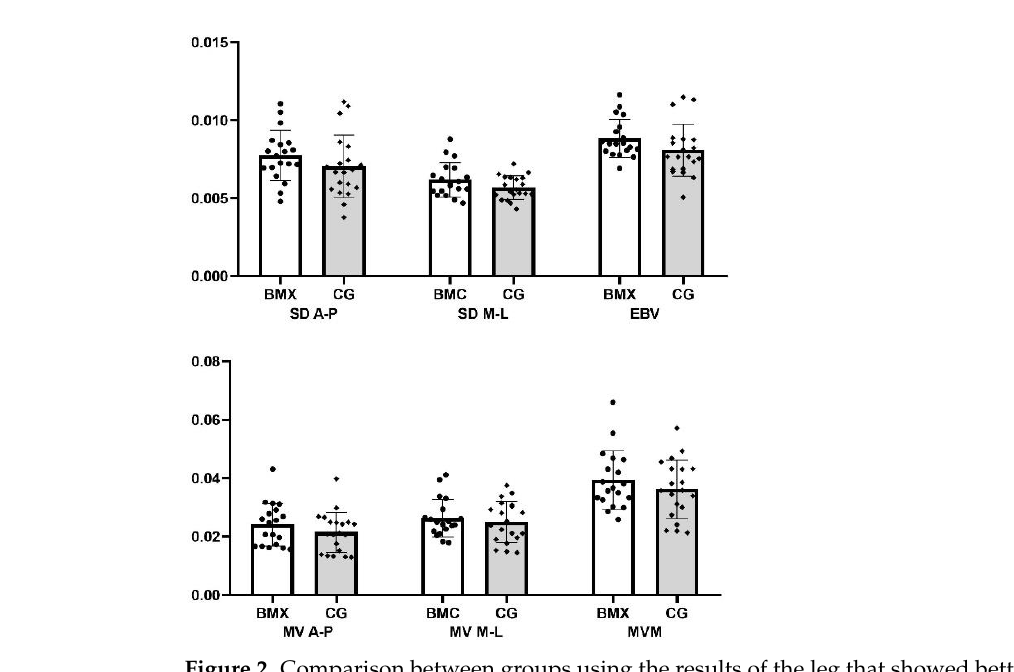
Figure 2. Comparison between groups using the results of the leg that showed better performance during the balance task (lower BVE). Units of center of pressure (COP) measures are as follows: cm (SD, BVE); cm/s (MV, MVM).